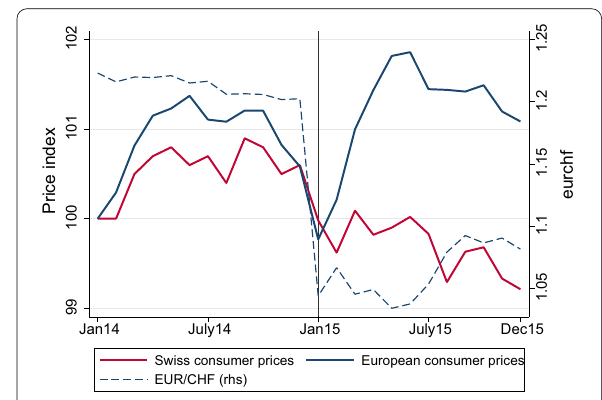
Fig. 1 Aggregate consumer prices before and after the currency appreciation. Notes Monthly HICP all-items index with January 2014 prices normalized to 100. Europe is a GDP-weighted price average of 33 European countries excluding Switzerland. Data source: Eurostat